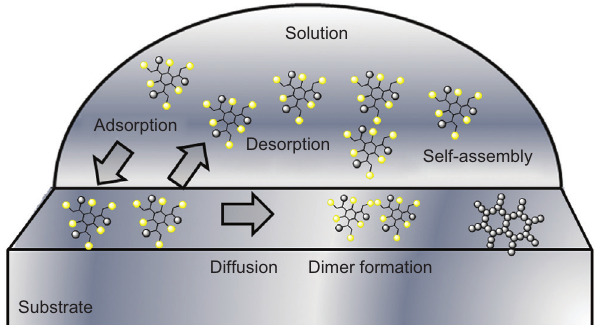
Figure 2 Schematic diagram of the self-assembly process to a supramolecular monolayer at a liquid-solid interface (redrawn from [28]).